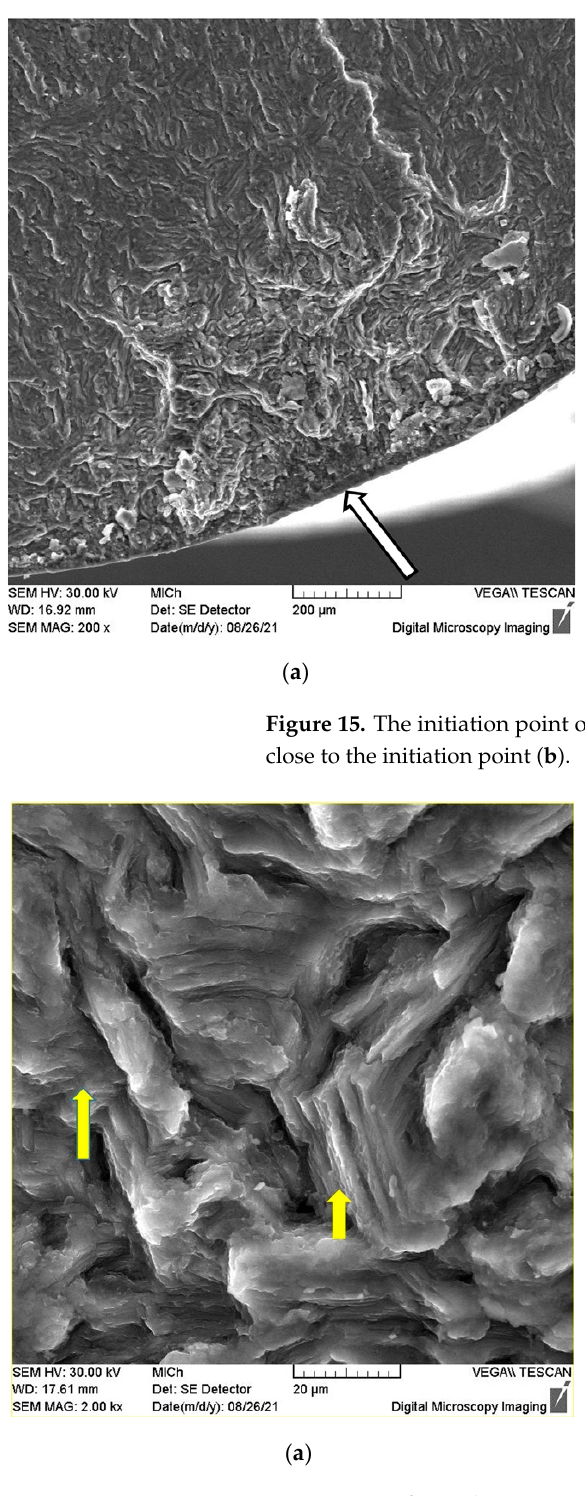
Figure 16. Deformed grains on the surface of the fracture and traces of the basal planes ( a ), river morphology, and secondary cracks on the surface of the fracture ( b ).